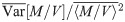
Comparison with experimental dataset of Taniguchi et al.(A): The normalized CV of mRNA concentration (defined as Var¯[M/V]/〈M/V〉¯2) for each gene predicted by the complete model (in yellow, the corresponding experimental measurements). (B): The CV of protein concentration for each gene predicted by the complete model (in yellow, the corresponding experimental measurements).